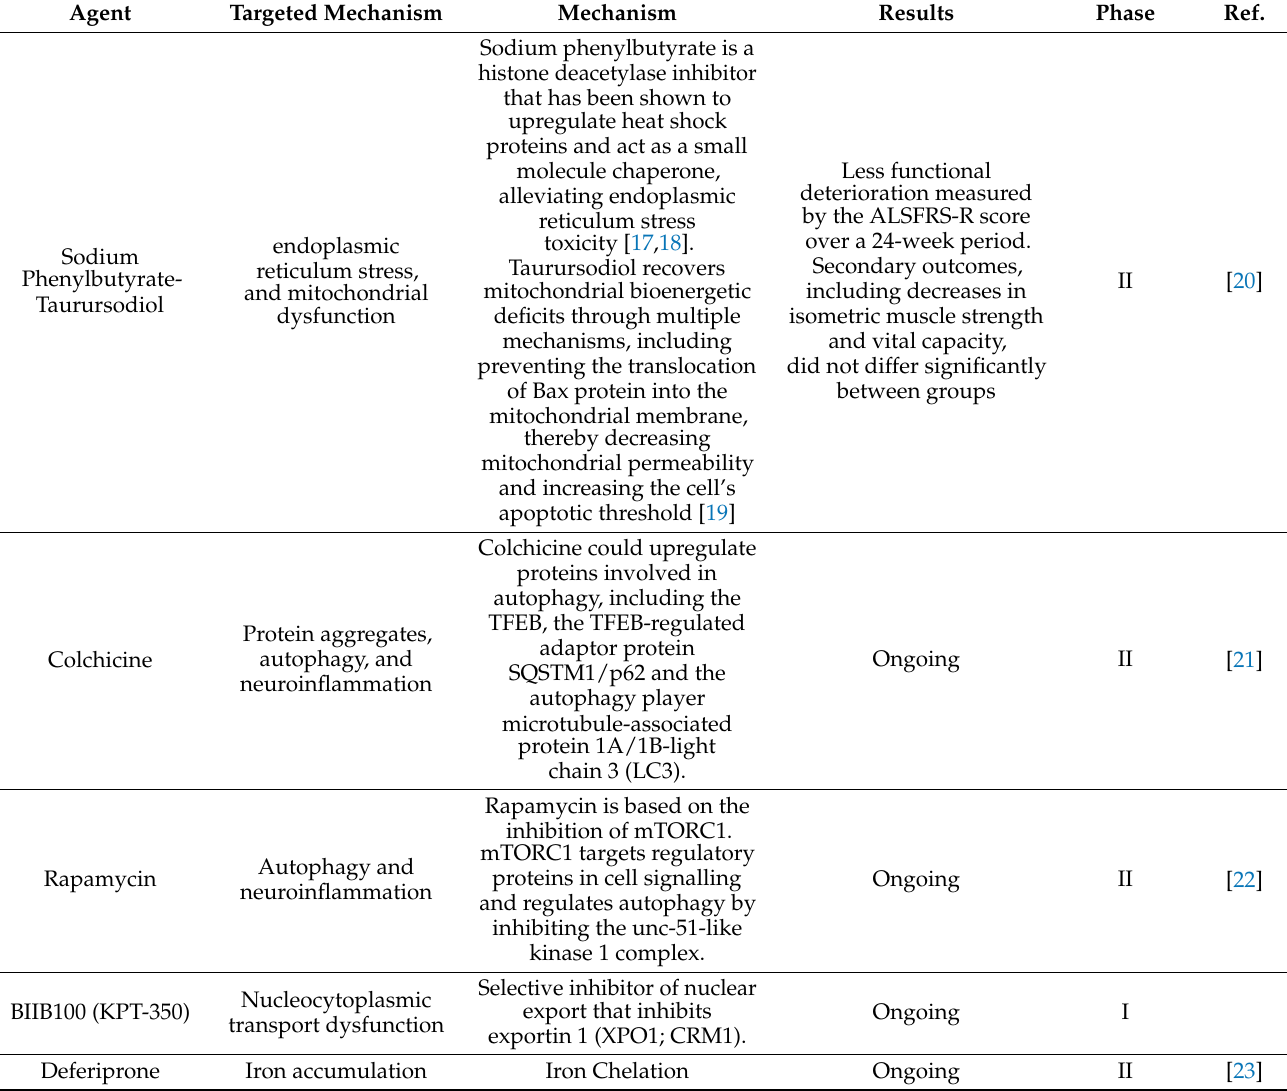
Table 1. A non-exhaustive list of therapeutic agents in development for ALS. Mechanism Results Phase